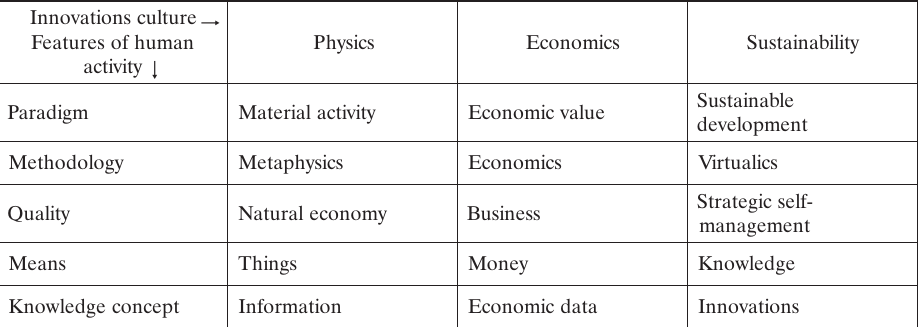
Table 1. Qualitative matrix of innovations culture erutlucsnoitavonnI namuhfoserutaeF ytivitca